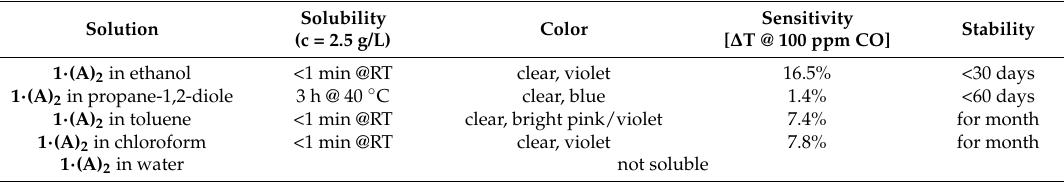
Table 3. Overview of the solubility, color, stability and CO sensitivity of 1 · (A) 2 dissolved in five different solvents.